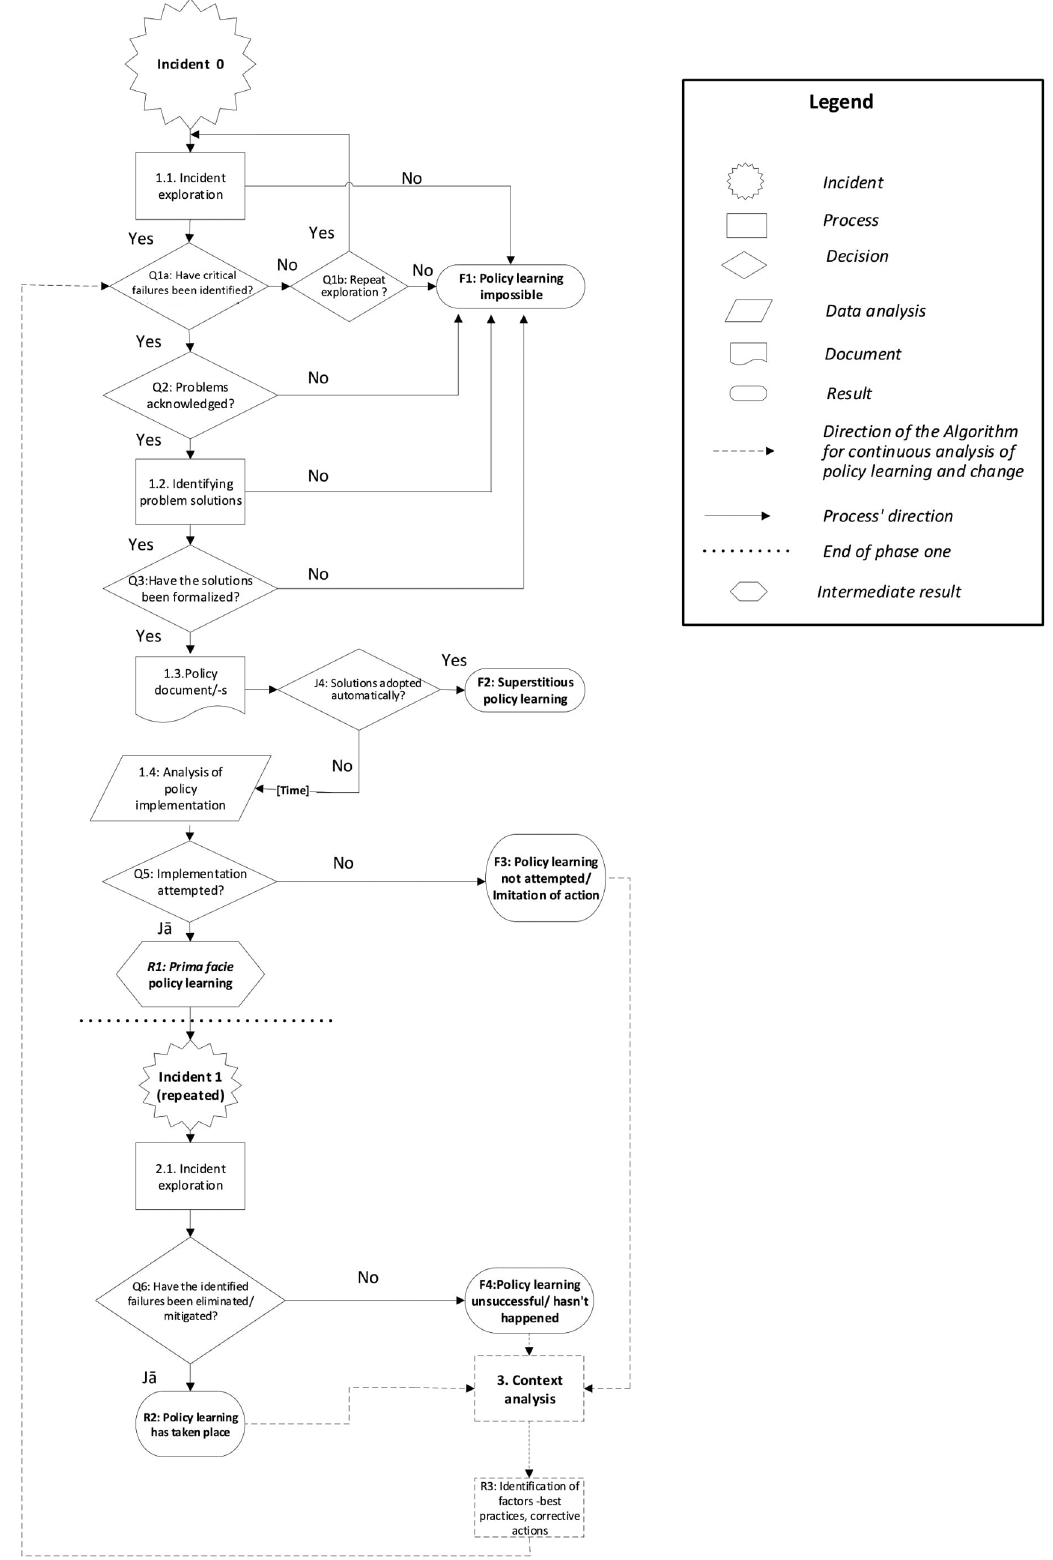
Figure 1. Algorithm for continuous analysis of policy learning and policy